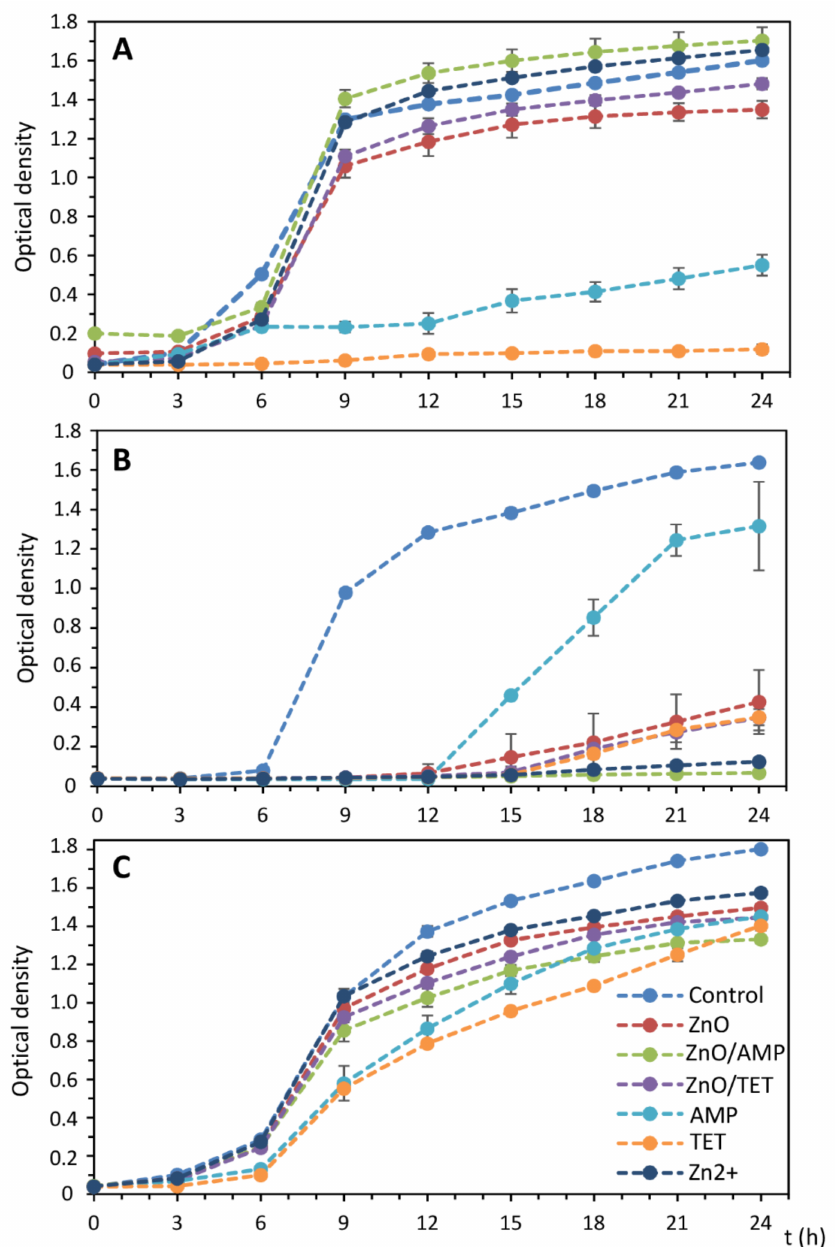
Figure 8. Growth kinetics of non-treated E. coli ( A ), S. epidermidis ( B ) and K. pneumoniae ( C ) bacteria cells, as well as after treatment with ampicillin (AMP), tetracycline (TET), zinc ions (Zn 2+ ) and zinc oxide nanoparticles (ZnONPs) before and after immobilization with AMP (ZnONPs/AMP) and TET (ZnONPs/TET), at a concentration of 25% of MIC